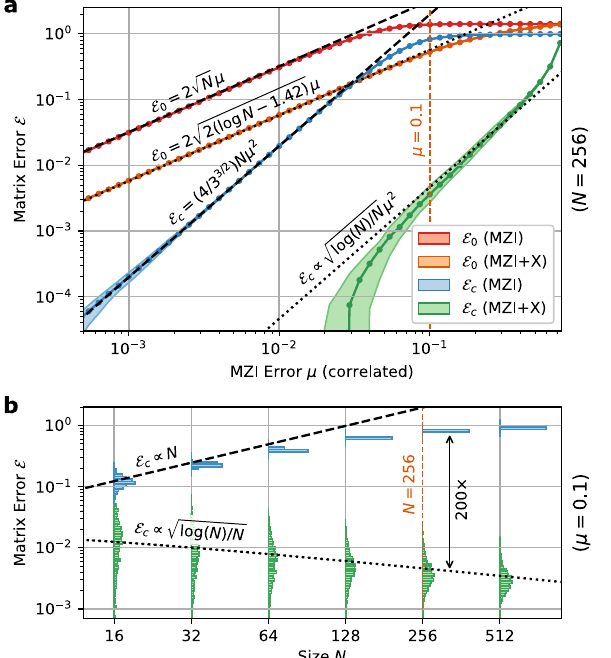
Fig. 6 | Advantages of MZI+crossing architecture for correlated component errors. a Dependence of matrix error E 0 , E c on splitter error μ ( fi xed N =256). b Dependence of E c on mesh size N ( fi xed μ =0.1).